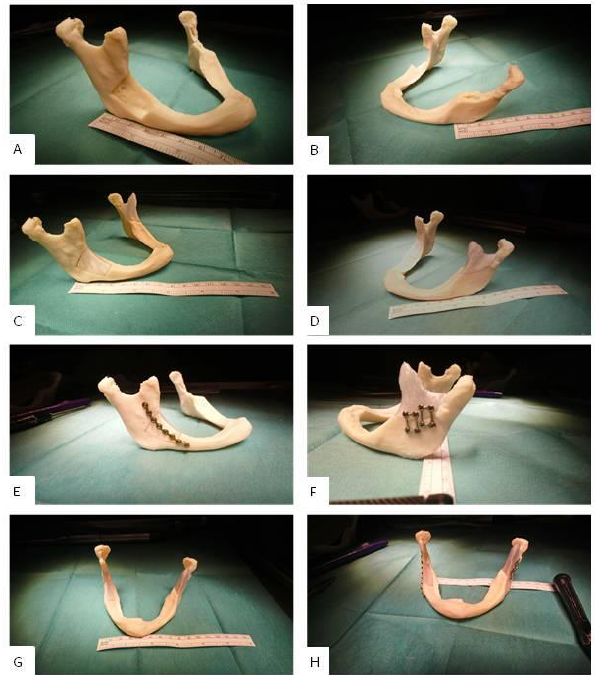
Figure 6. Clinic-internal assembly of the maxillofacial standard implants A [7] and B with